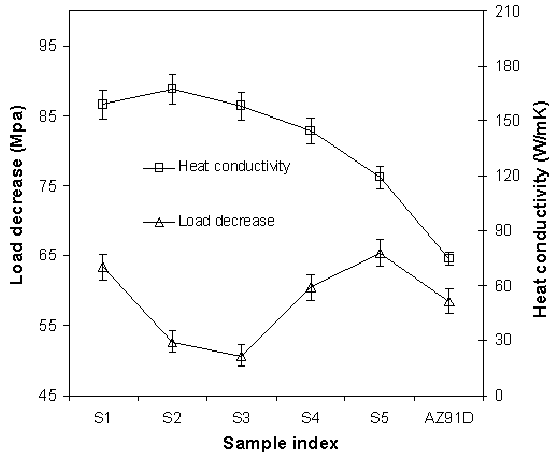
Figure 1. Heat conductivity and load decrease measurements. The sample index relates to Table 1.